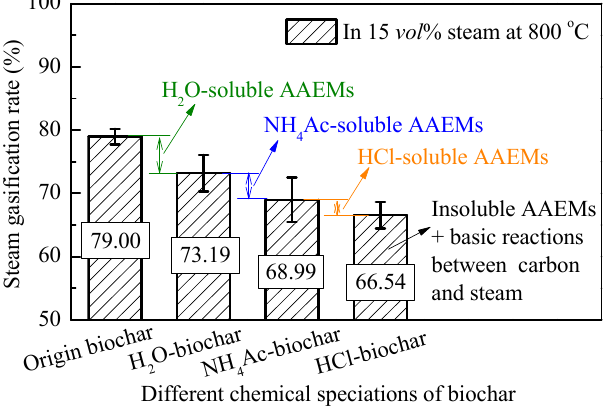
Figure 4. Steam gasification rate of biochar from chemical analysis fractionation.